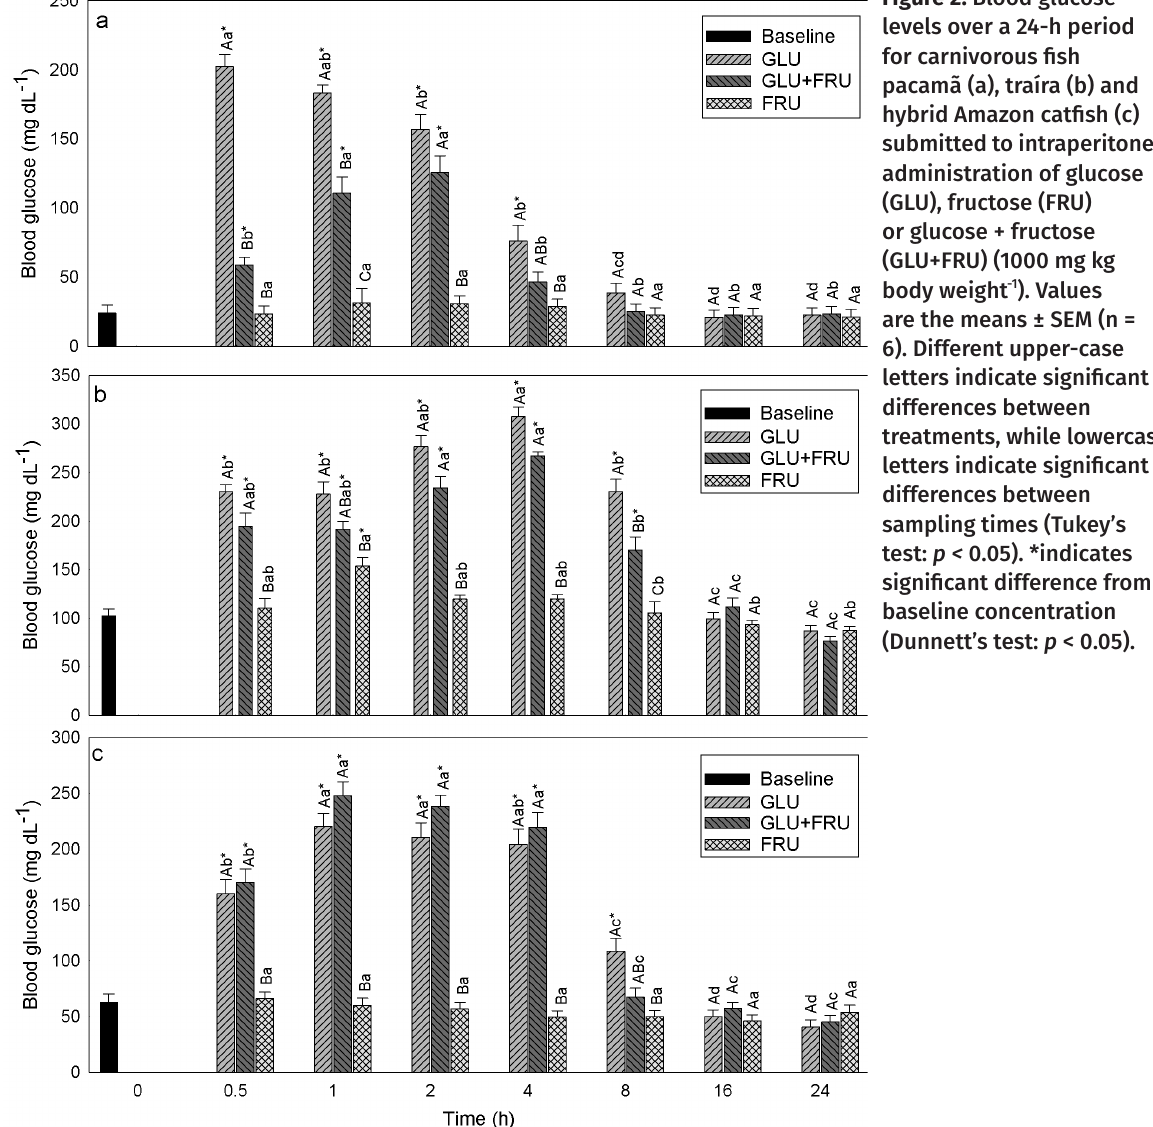
Figure 2. Blood glucose levels over a 24-h